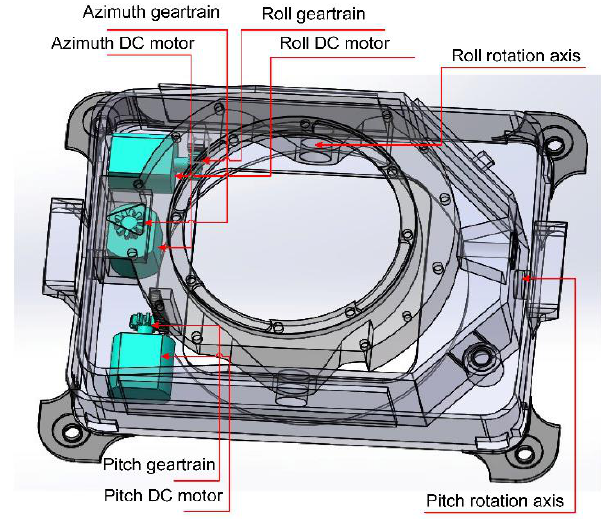
Figure 2. Three-dimensional structure of the ARSSP.